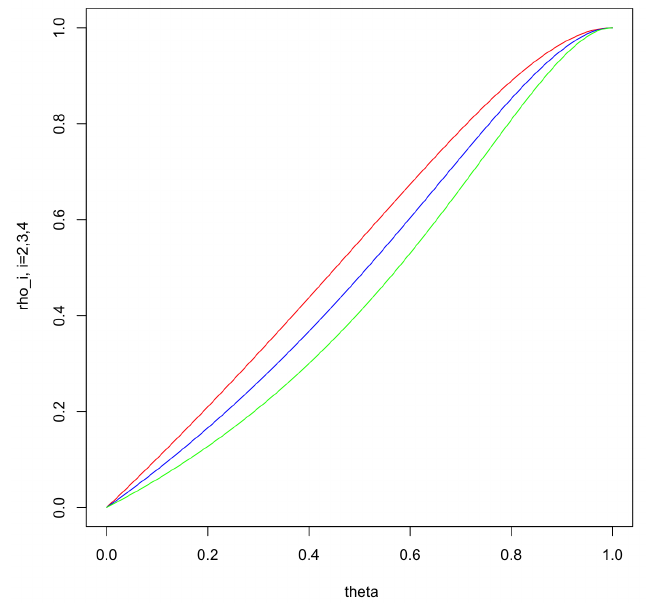
Figure 1. The curves of ρ 2 , ρ 3 and ρ 4 in terms of θ are indicated with colors red, blue and green,